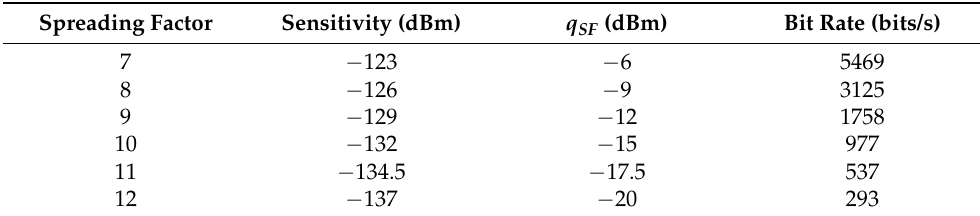
Table 1. Receiver sensitivities for different spreading factors and the corresponding bit rates. The parameter q SF indicates the specific noise threshold for a given spreading factor. Values are taken from Georgiou and Raza